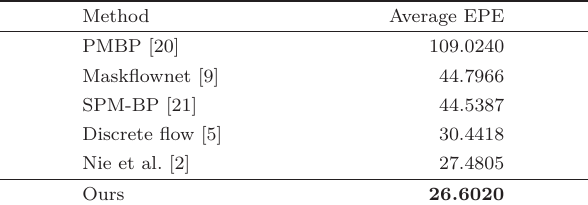
Table 3 Motion error (EPE) for the MVS-Synth dataset